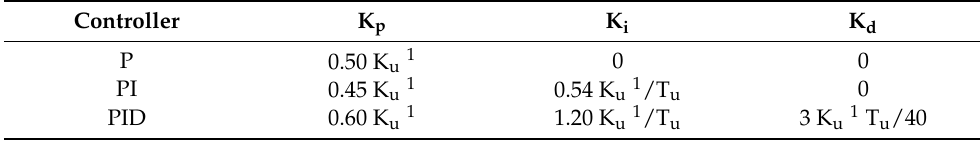
Figure 16. The change of pressure about step response. Table 5. Ziegler–Nichols formula for PID controller tuning rules.